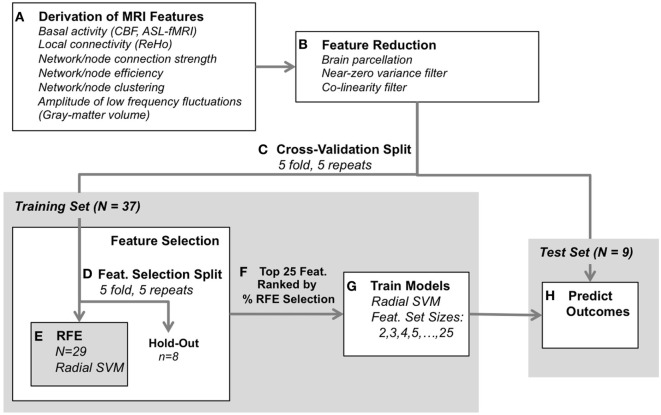
Classification analysis design. (A) Functional and structural data were first preprocessed using standard protocols, and metrics were derived to reflect various aspects of brain-network connectivity [blood-oxygenation-level-dependent-functional magnetic resonance imaging (fMRI)], basal activity levels [arterial spin labeled (ASL)-fMRI], and gray-matter volume (structural MRI). (B) Next, feature reduction steps derived the average metric for each region of interest (defined by the Craddock atlas), and removed features with near-zero variance and high collinearity. (C) Remaining data were split into training and test Sets. (D–F) The training set was submitted to feature selection using recursive feature elimination (RFE, radial SVM) to select the 25 most consistently selected multimodal MRI features, validated with 5-repeated 5-fold splits of the training set (resulting in 25 iterations through RFE per each outer cross-validation split). (G) A radial SVM classifier was then trained using the training set and the top 25 features ranked by selection consistency. These models included several feature-set sizes, including the top 2 features, top 3, top 4, through top 25 features. (H) Finally, each model’s ability to predict electroconvulsive therapy outcome was assessed using the test set. The process was validated across 5-repeated 5-fold cross-validation splits [i.e., (C)] for 25 total model predictions for each feature-set size (2–25 features).